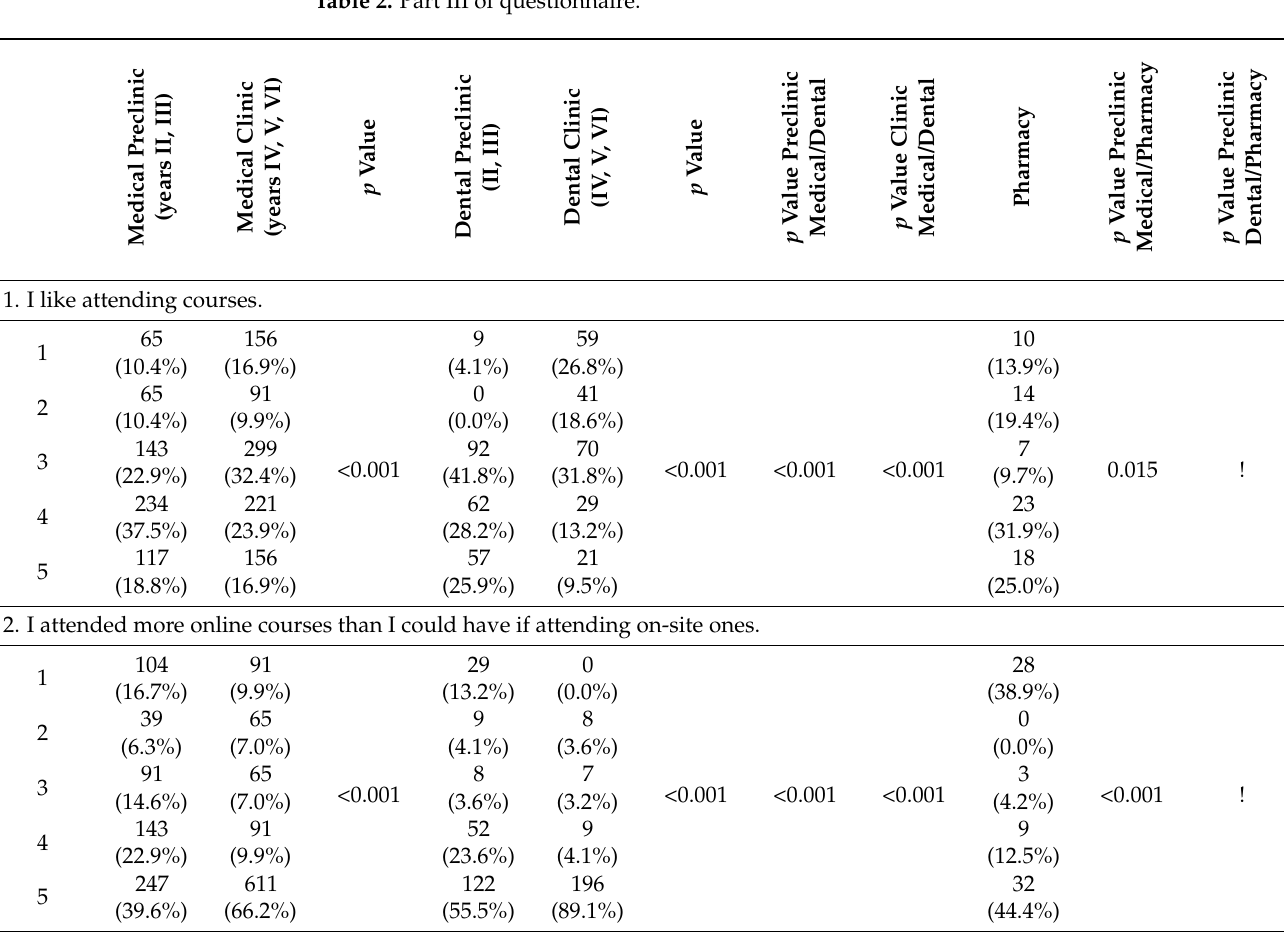
Table 2. Part III of